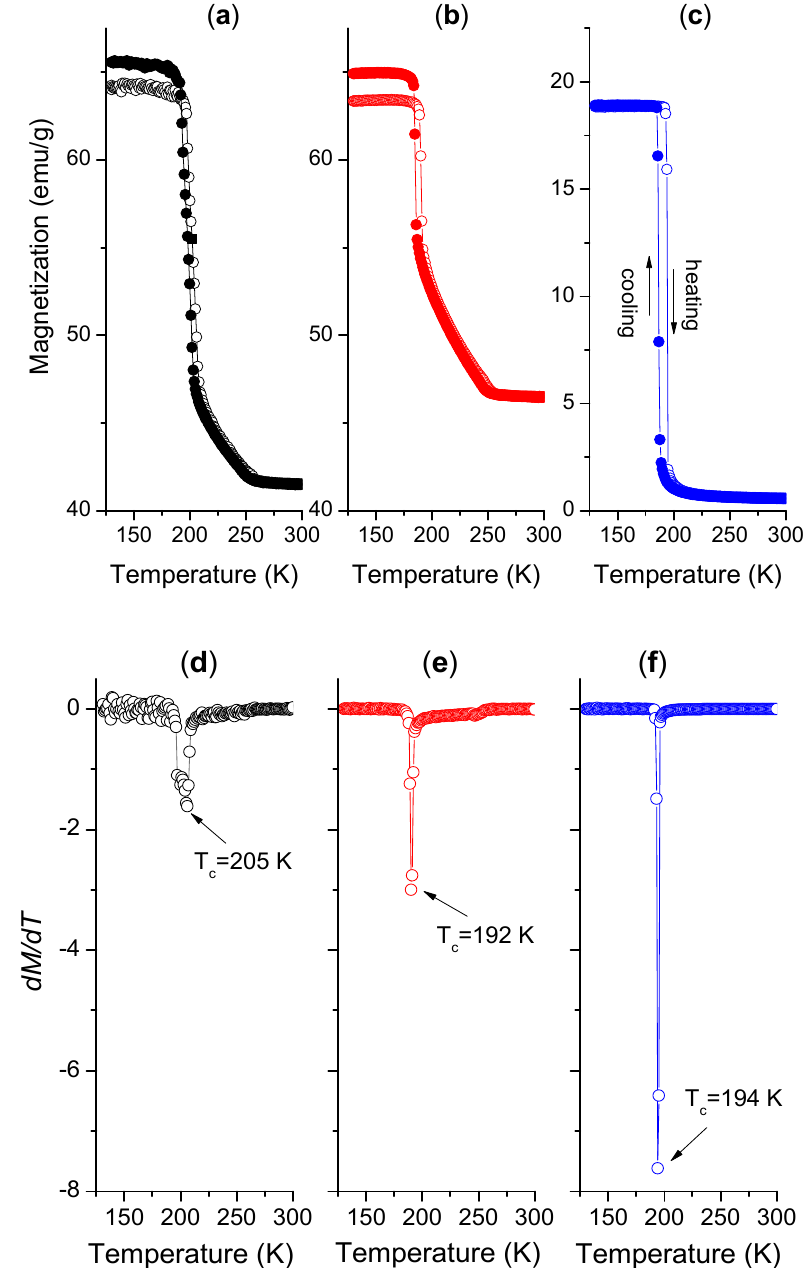
Figure 5. Magnetization curves measured under a low magnetic field of 0.05 T for annealed LaFe 11.6 Si 1.4 ( a ), LaFe 11.6 Si 1.4 Zn 0.03 ( b ), and LaFe 11.6 Si 1.4 P 0.03 ( c ), respectively. Plots ( d – f ) are the corresponding d M / d T curves upon heating.